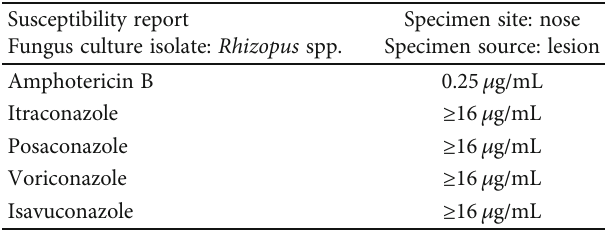
Table 5: Patient 3